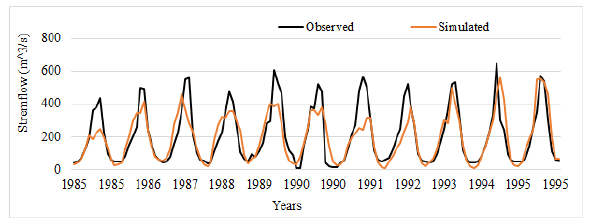
Table 1. Mean, standard deviation, R 2 and Nash-Sutcliffe of the observed and simulated discharge of the basin